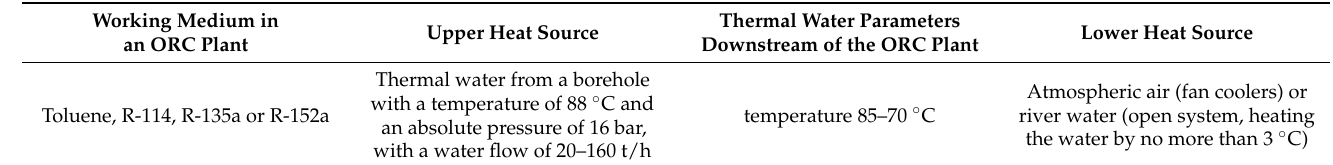
Table 3. Design data for the ORC plant within the system under